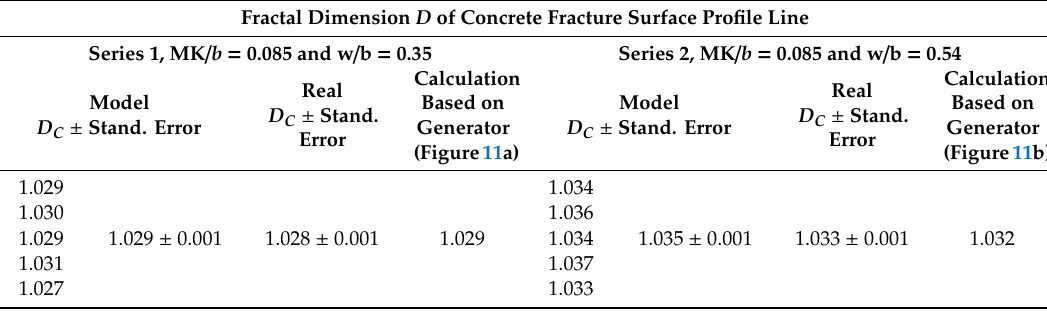
Table 4. Fractal dimension of model profiles vs. fractal dimension of real profile lines. Fractal Dimension D of Concrete Fracture Surface Profile Line Series 1, MK / b = 0.085 and w / b =